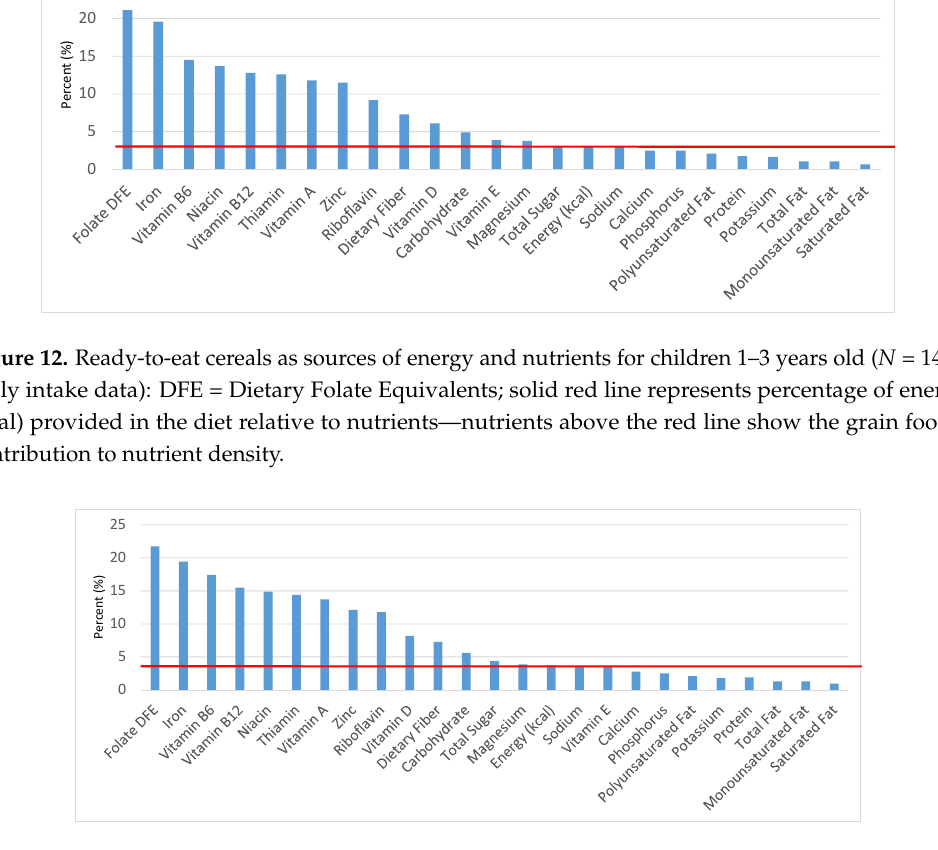
Figure 13. Ready ‐ to ‐ eat cereals as sources of energy and nutrients for children 4–8 years old ( N = 1917, daily intake data): DFE = Dietary Folate Equivalents; solid red line represents percentage of energy (kcal) provided in the diet relative to nutrients—nutrients above the red line show the grain food’s contribution to nutrient density.